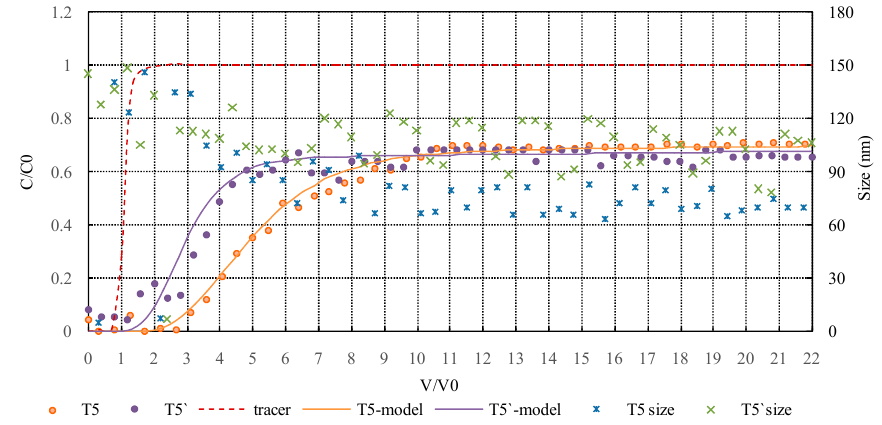
Figure 7. Experimental breakthrough curves for colloidal silica with and without HA in mixed solution.